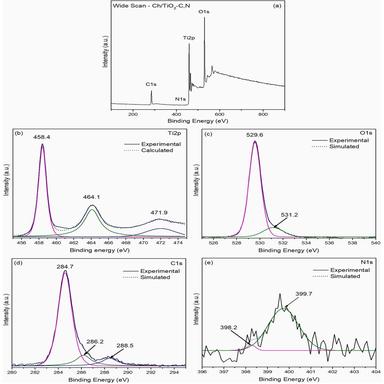
(a) Wide-scan XPS spectra of Ch/TiO2–N, C. XPS core spectra of, b) Ti 2p, c) O1s, d) C1s and e) N1s of the catalyst.